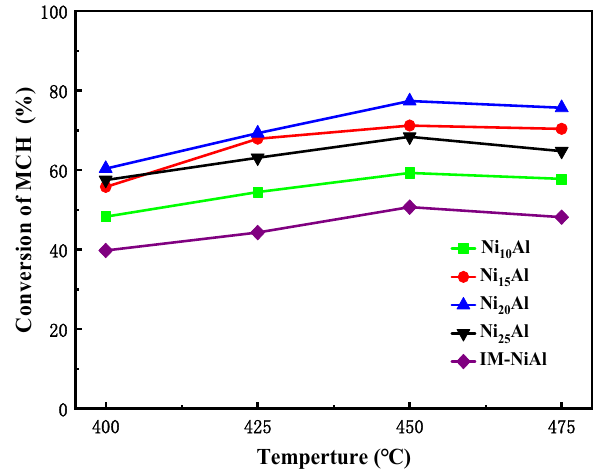
Figure 5. Effect of Ni content on dehydrogenation conversion of MCH.